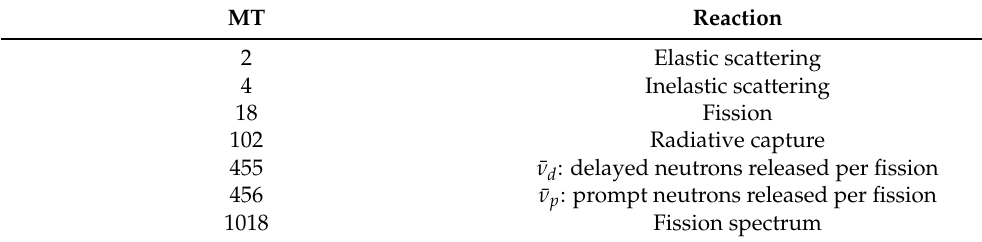
Figure 9. Uncertainty quantification approach. Table 1. Nuclide reactions analyzed in the uncertainty quantification